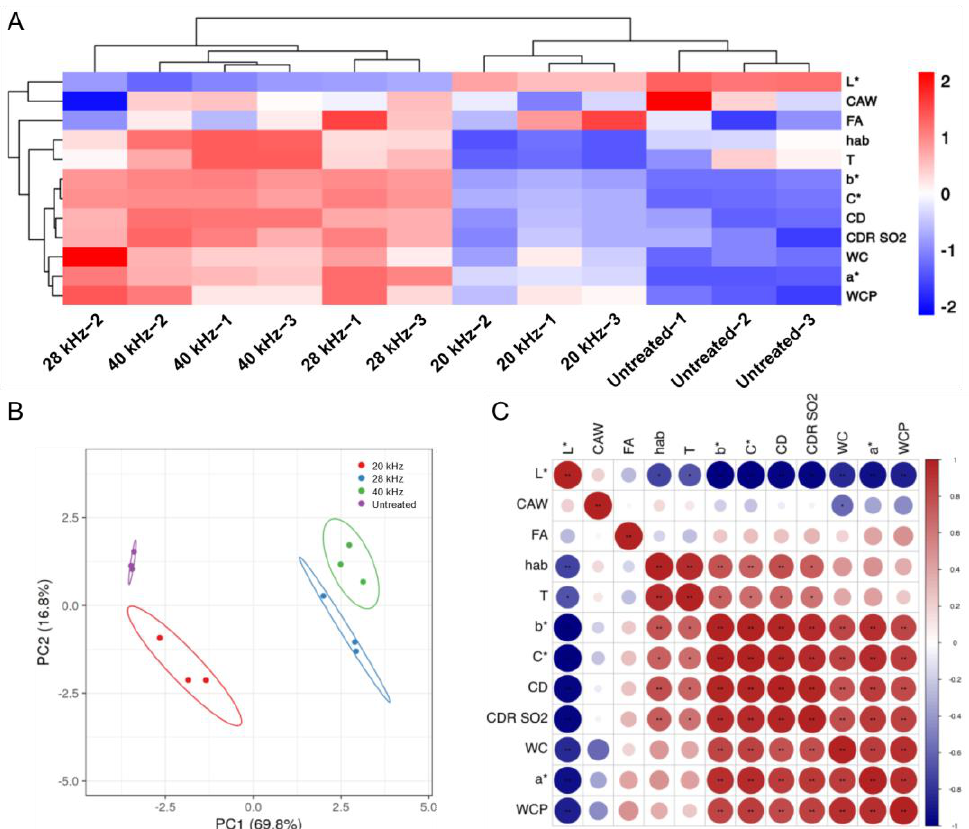
Figure 3. Clustering analysis and principal component analysis for the Sanhua plum wine and the correlation of different color parameters in Sanhua plum wine. ( A ) Clustering analysis for Sanhua plum wine with or without ultrasonic treatment after three-month aging considering the normalized indexes comprising the L* , a* , b* , hab , C* , WCP, WC, CD, T, and CDR SO 2 . ( B ) Principal component analysis. ( C ) Correlation of different color parameters. * p < 0.05, ** p < 0.01, indicating a significant correlation between the two parameters.